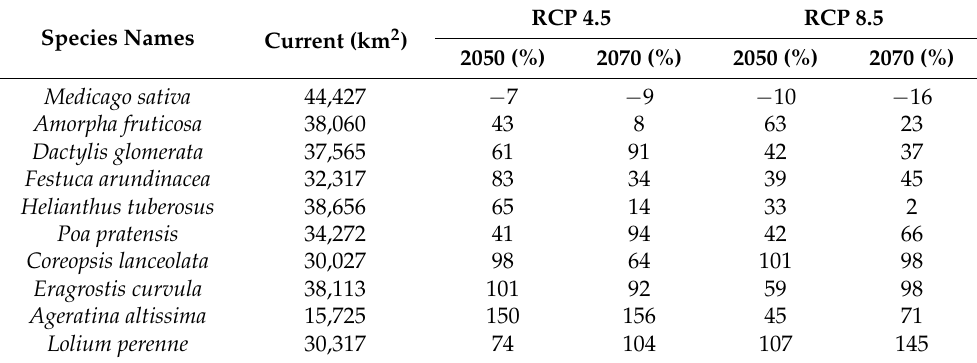
Table 4. Relative change in the spatial distribution of IIAPS in South